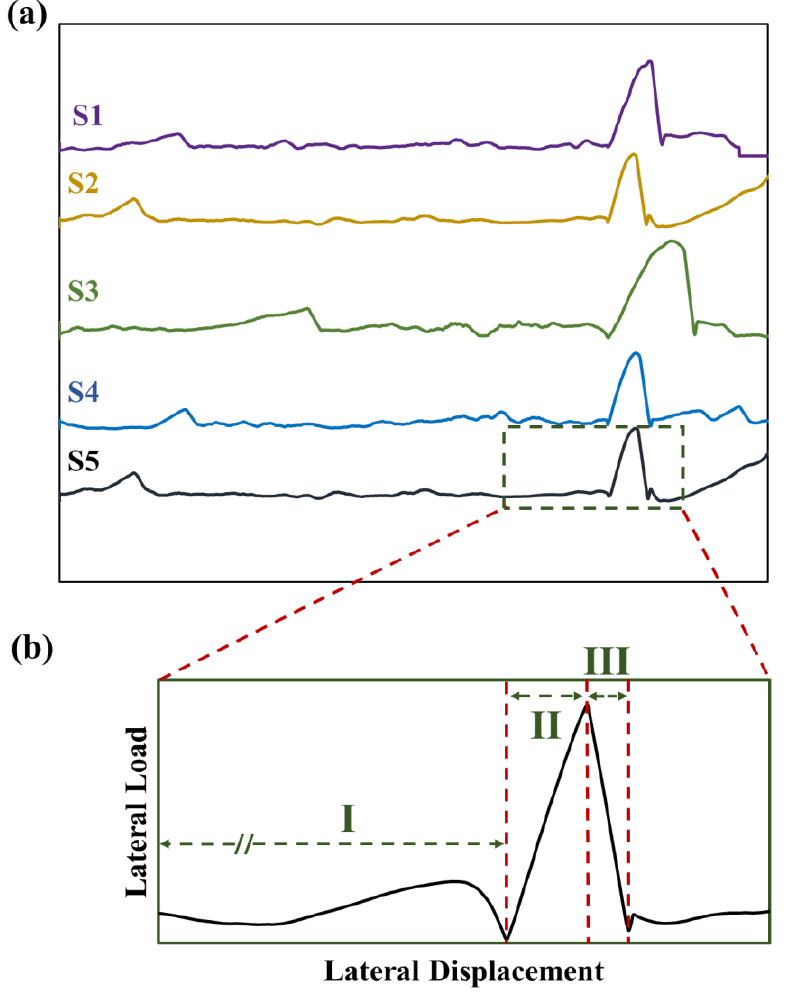
Figure 6. ( a ) P–h curves obtained from the push-out tests and ( b ) the three distinct stages (Stage I, II and III).